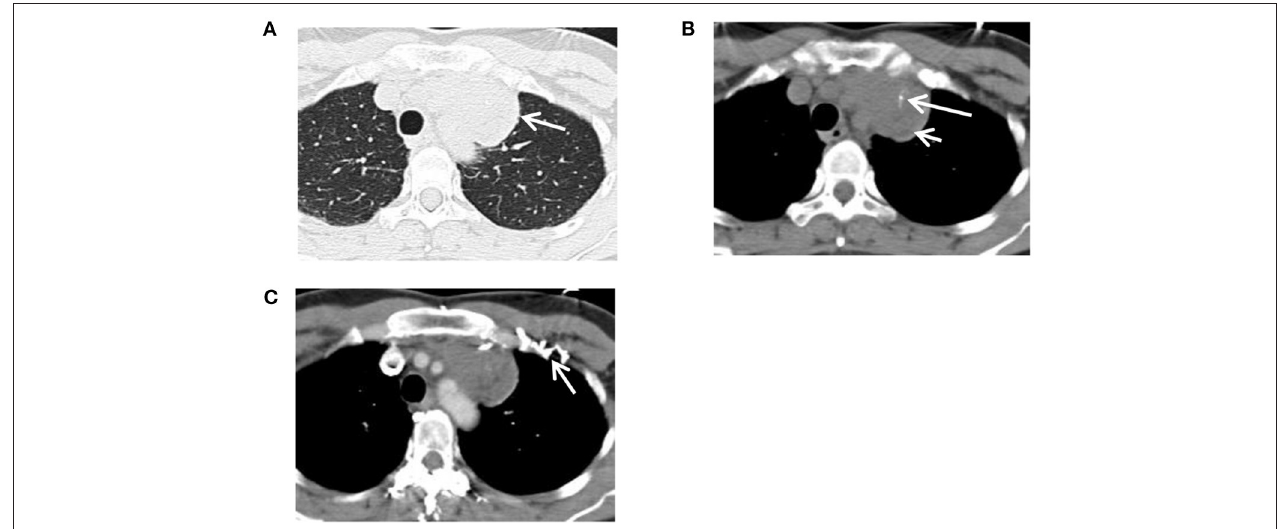
FIGURE 1 | CT of a 49-year-old female patient with mediastinal epithelioid haemangioendothelioma (EHE) at the first treatment. (A) An unenhanced CT revealed a mass in the left anterior mediastinum, and the interface between the lung and the mass was smooth (arrow). (B) Spotted calcification (long arrow) and fatty foci (short arrow) were observed inside the mass, and the lesion was closely connected with mediastinal vessels and the anterior chest wall. (C) An enhanced CT of the venous phase indicated a mass with asymmetrical mild enhancement, and the collateral circulation of the left upper chest wall was opened abnormally